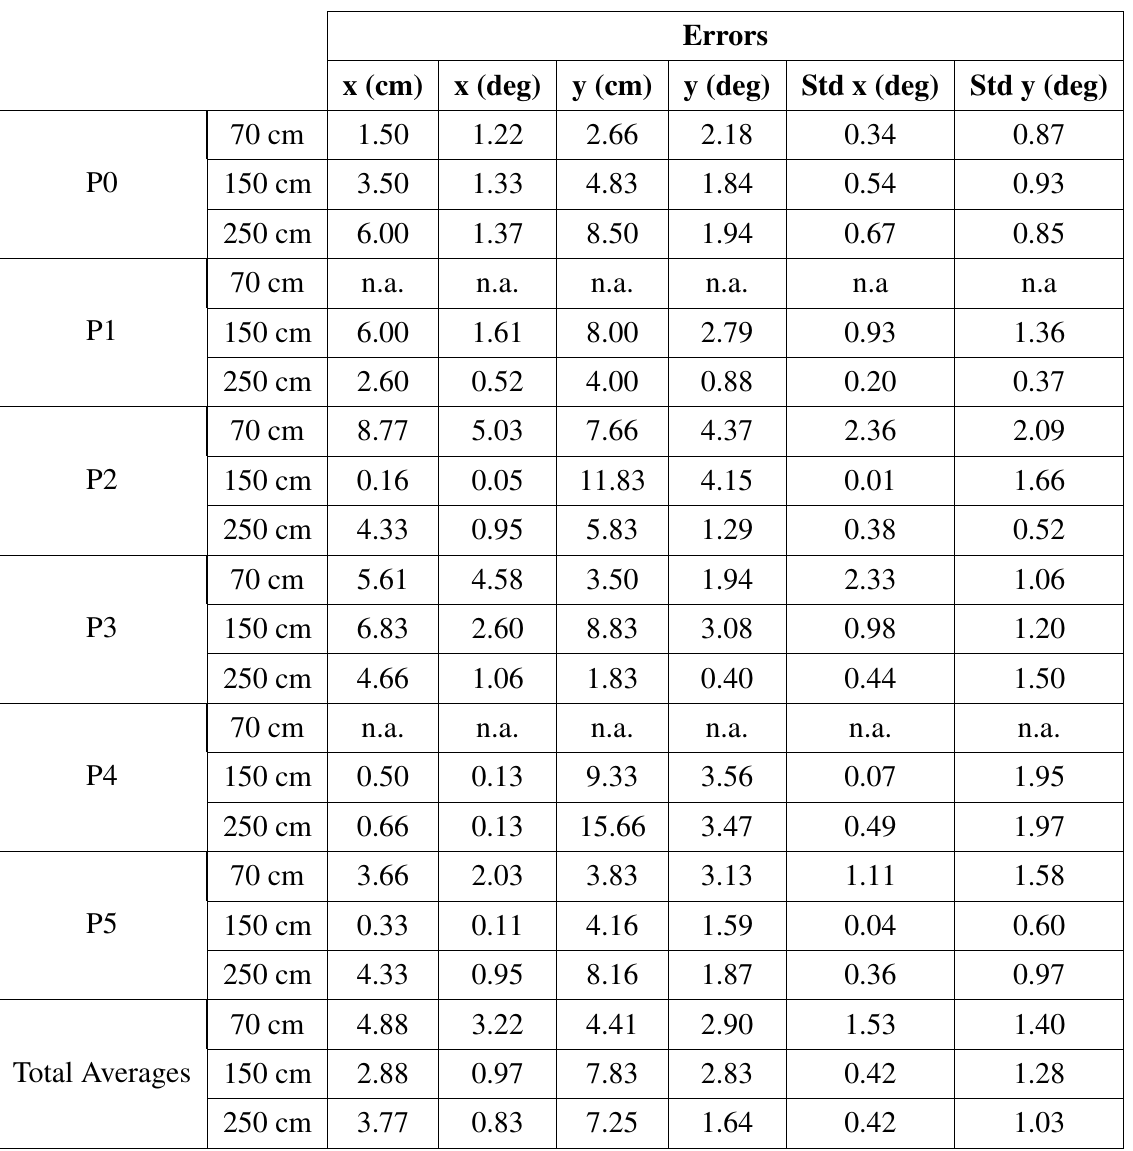
Table 1. Experiments with the first group of experienced persons: they knew how the system works and that already tried the system before the test